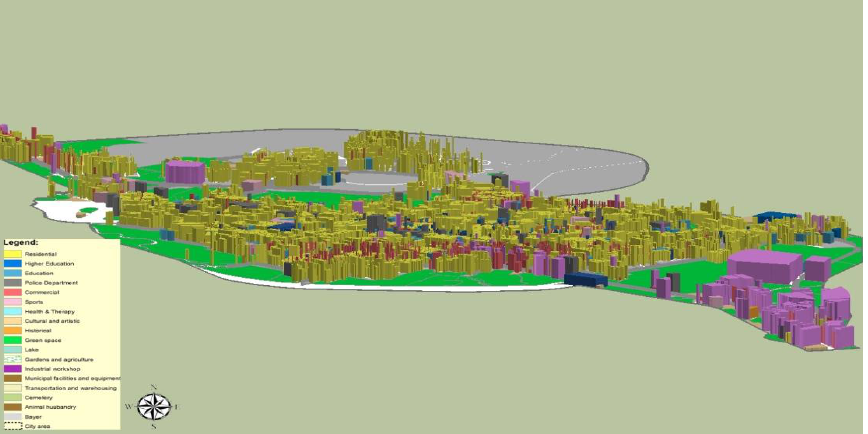
Figure 3. The 3D model of the urban buildings in Borujerd. With an analysis of the above data, Table 2 gives a tabular representation of the buildings. Table 2. The data on the floors of the residential buildings and their usable